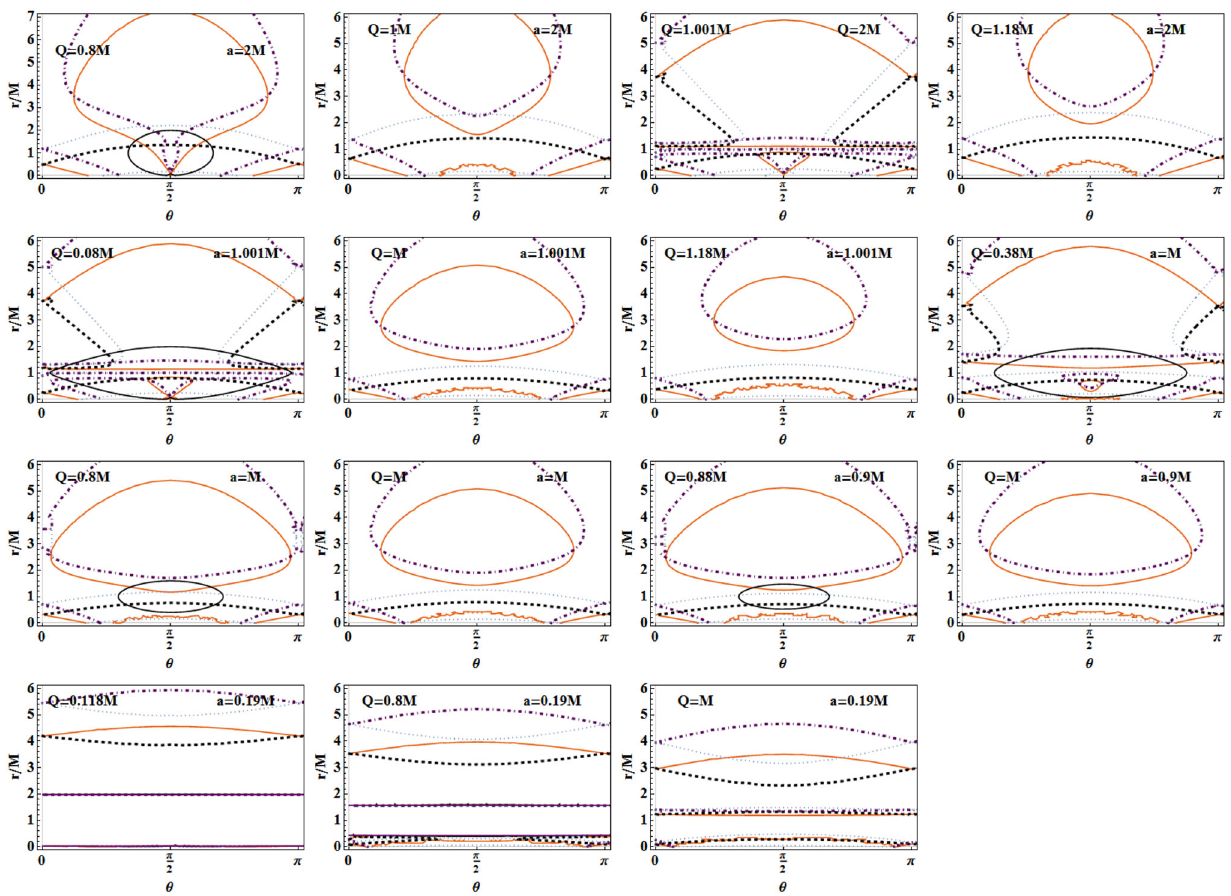
Fig. 29 Kerr–Newman spacetimes: off-equatorial analysis. Solutions of ∂ 2 r ω ± = 0 (orange and dashed curves) and ∂ 3 r ω ± = 0 (dotted and dotted-dashed curves), defining the Killing bottleneck of naked sin-